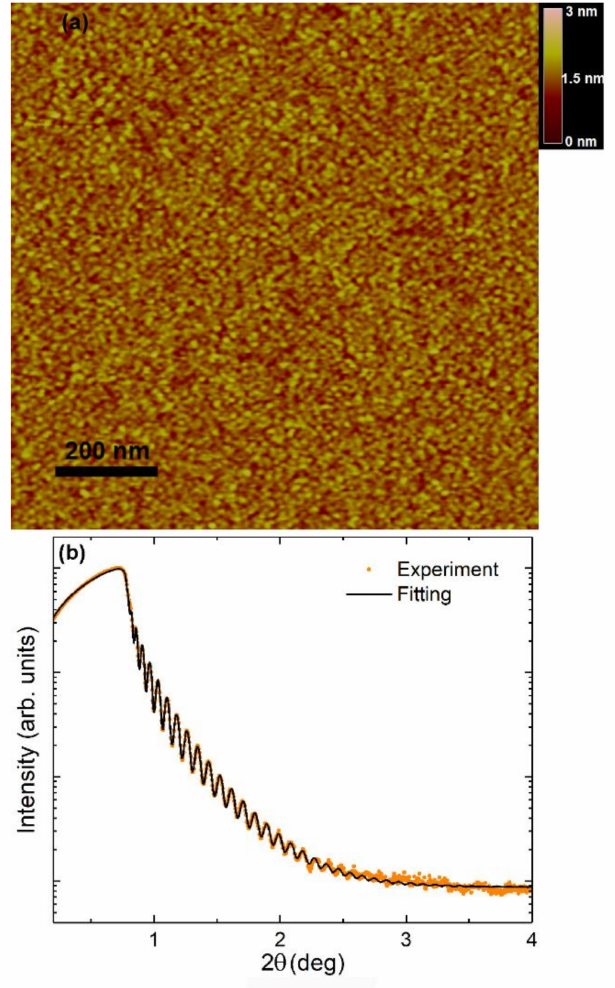
Figure 2. ( a ) AFM image of the surface of a single NiFe thin film with t = 84 nm. Color scalebar to show roughness is added. ( b ) XRR